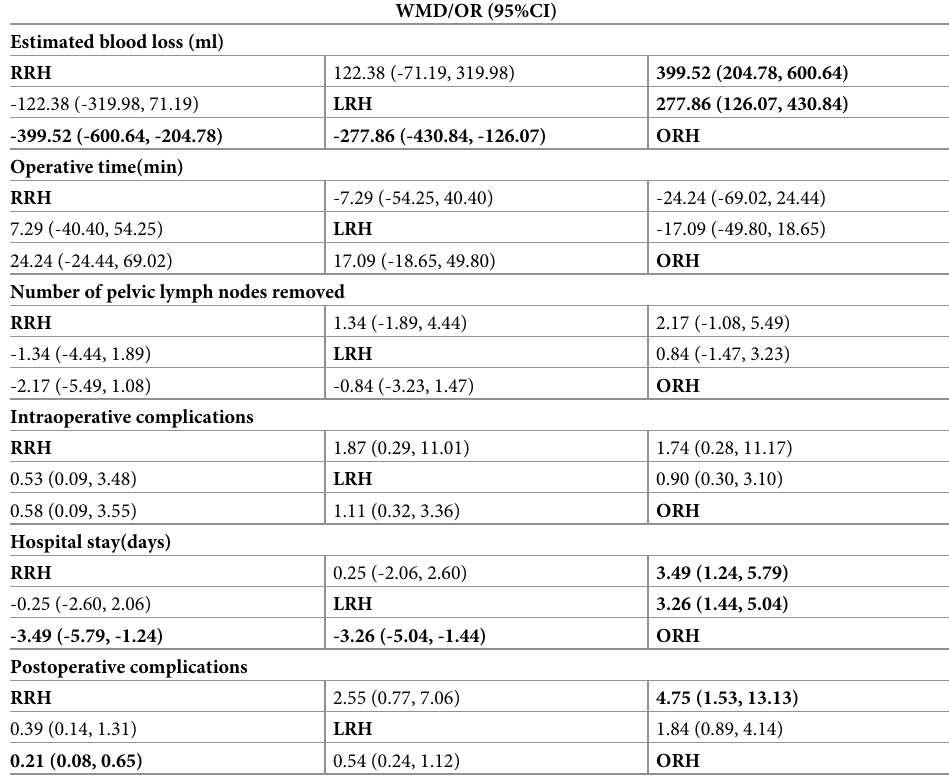
Table 2. Weighted mean difference or odds ratio (95% confidence intervals) of three treatment modalities of six endpoint